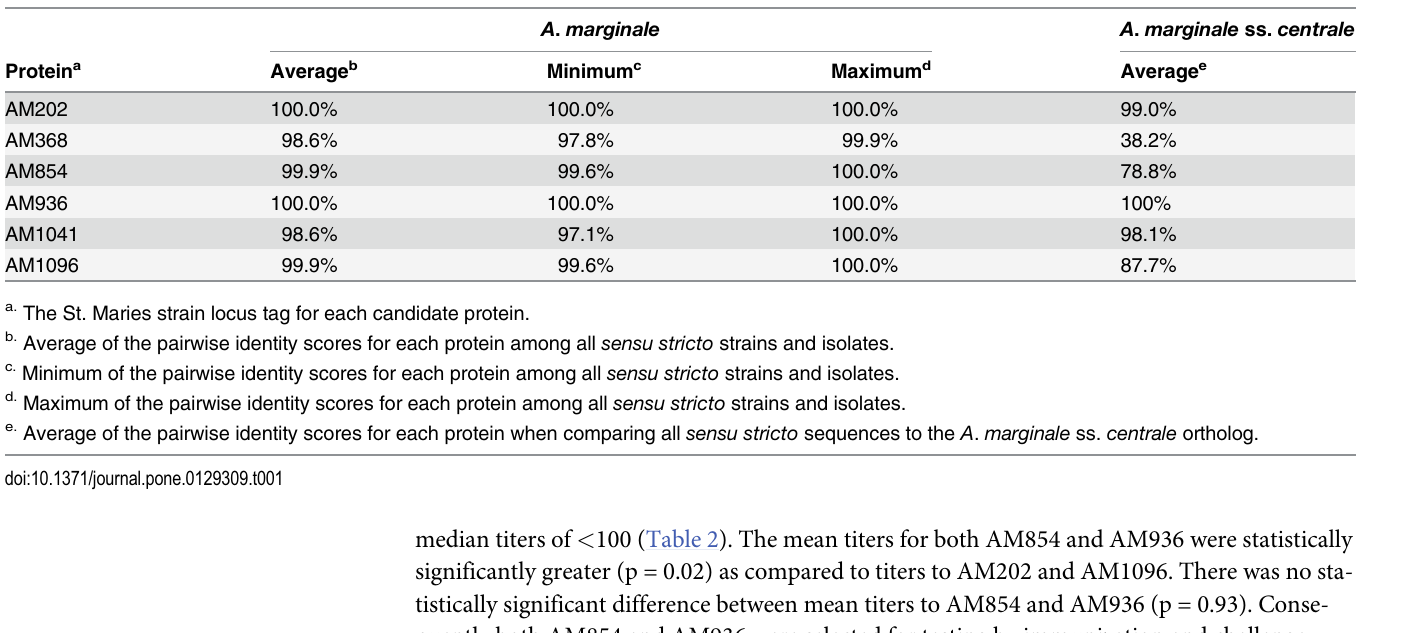
Table 1. Pairwise percent identity scores for each candidate protein.